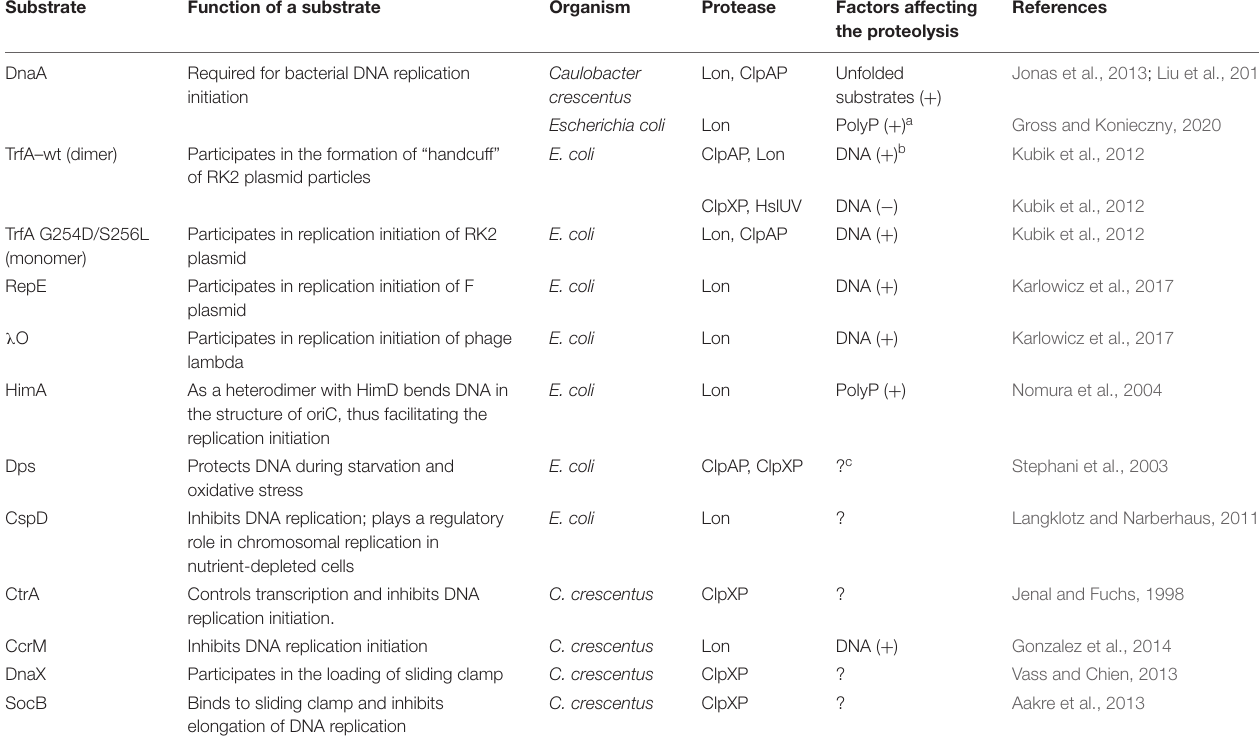
TABLE 1 | Comparison of degradation conditions of replication proteins and proteins associated with DNA replication.